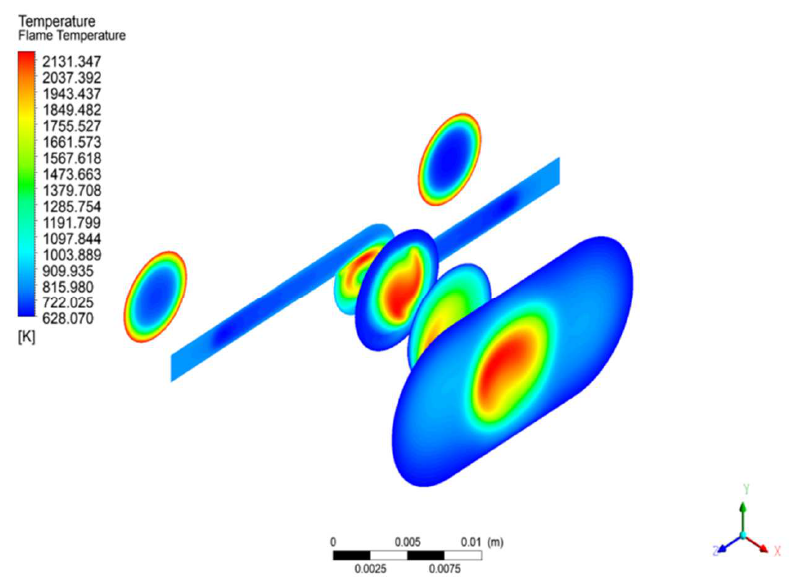
Figure 11. Temperature profile on cross section of x = 2, 8, 14, 20, and 26 in the vertical vortex combustor .